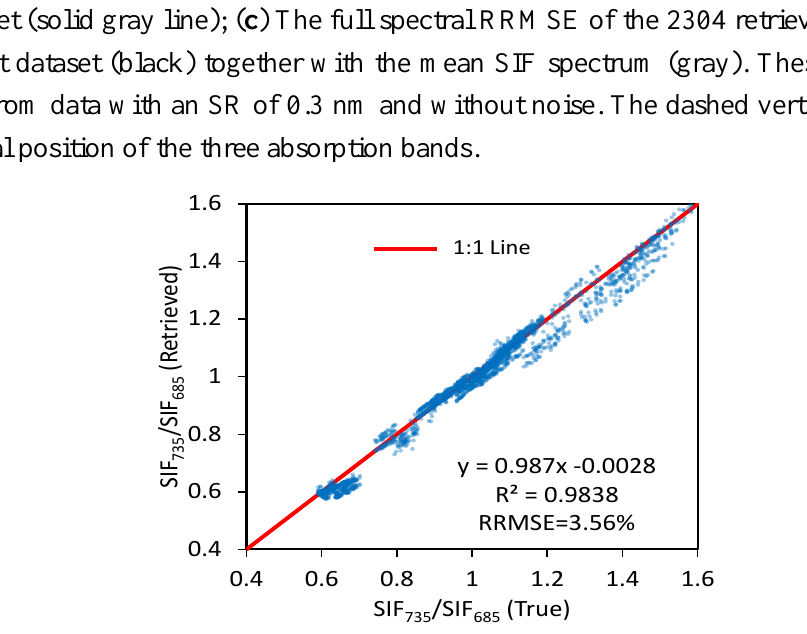
Figure 6. The correlation between the true values of SIF 735 /SIF 685 and those retrieved from the simulated test dataset (2304 samples with SR of 0.3 nm and without